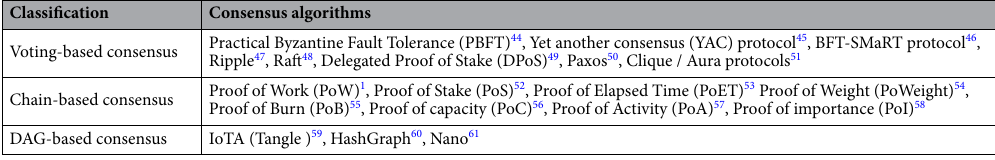
Table 2. Consensus algorithms in blockchain